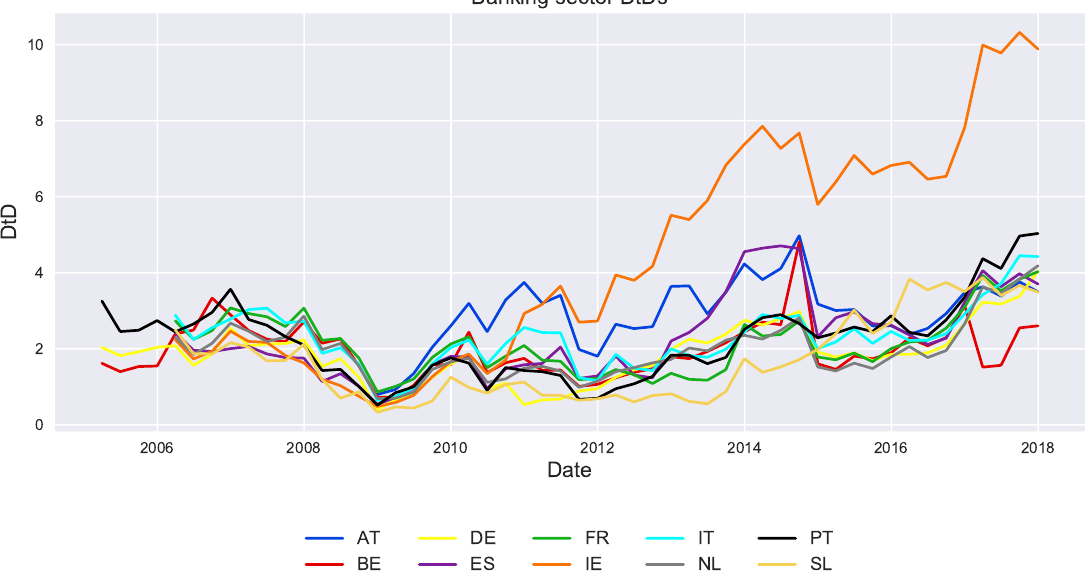
Figure 2. Banking sectors DtD s. The chart shows the level of aggregate banks’ DtD in the analysed countries (AT, BE, DE, ES, FR, IE, IT, NL, PT, SL) from 2005 to end 2017. The y -axis expresses this measure in standard deviations.